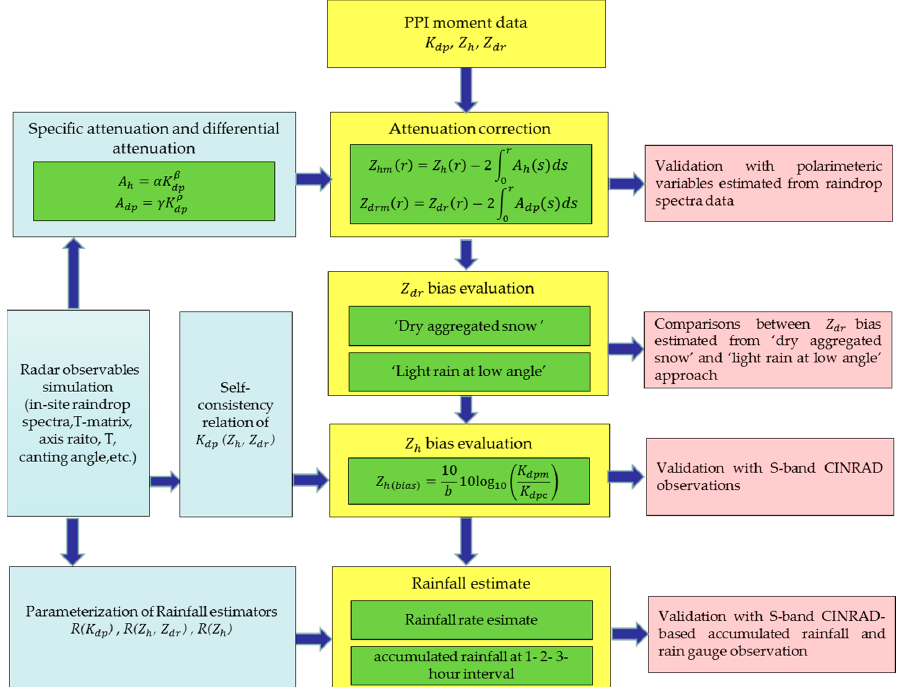
Figure 2. Flow diagram describing the procedure to evaluate the performance of XPRAD.